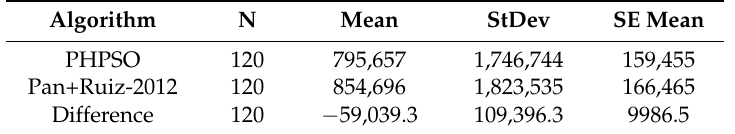
Table 9. Paired t -test for H 0 = PHPSO = Pan-Ruiz vs. H 1 = PHPSO (cid:54) = Pan-Ruiz on the best-known solutions. Algorithm N Mean StDev SE Mean PHPSO